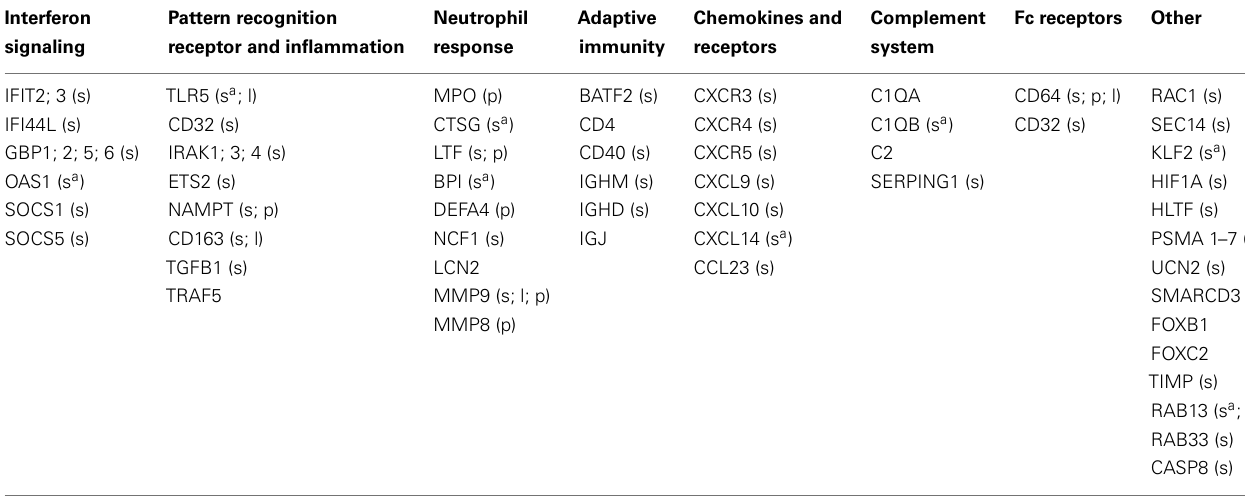
Table 1 | Genes identified as differentially expressed inTB compared to healthy controls and reported as a part of a biosignature . Interferon